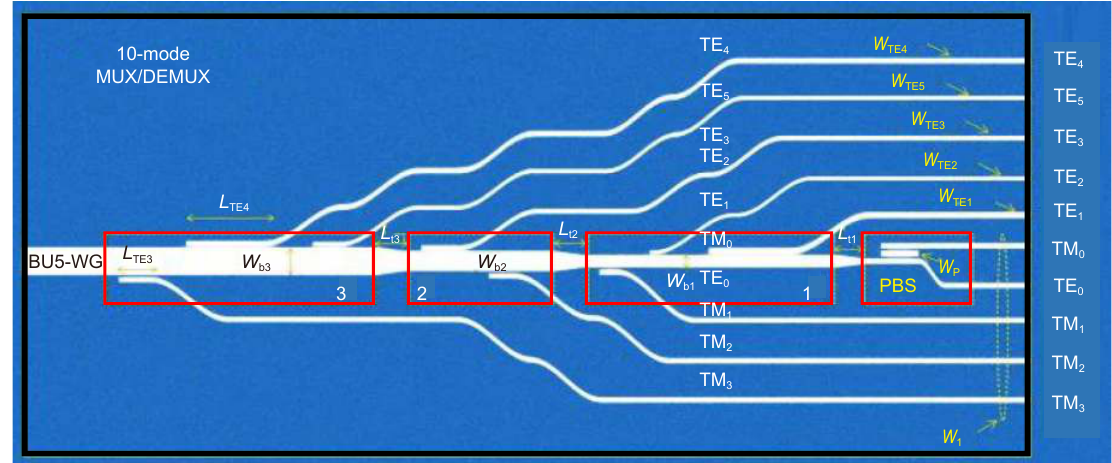
Fig. 16 | Graphical illustration of 10-mode hybrid MUX/DEMUX device for both TE and TM polarizations. Figure reproduced with permis- sion from ref. 13 , under a Creative Commons Attribution 4.0 International License.